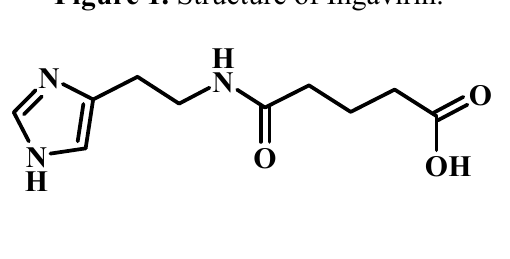
Figure 1. Structure of